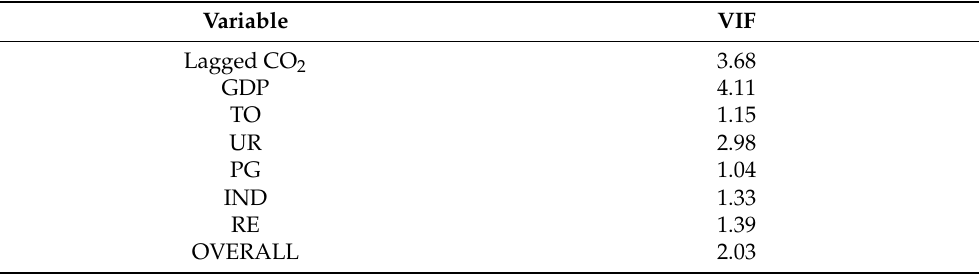
Table 2. Multicollinearity test